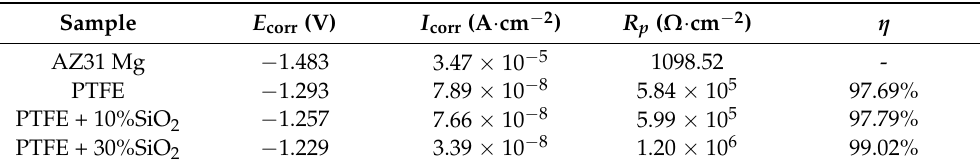
Figure 2. Potentiodynamic polarization curves of AZ31 Mg, PTFE, PTFE+10%SiO 2 and PTFE+30%SiO 2 coated samples. Table 1. The corresponding parameters of the PDP curves of AZ31 alloy, PTFE + 10%SiO 2 and Table 1. The corresponding parameters of the PDP curves of AZ31 alloy, PTFE+10%SiO 2 and PTFE PTFE + 30%SiO 2 coated + 30%SiO 2 coated samples.